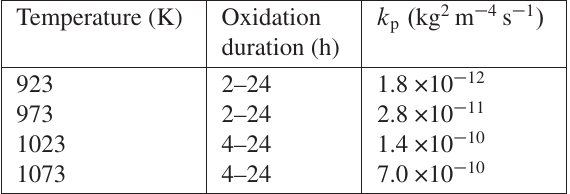
Table 1. Parabolic rate constants for the isothermal oxida- tion of the coating/TA15 in air.